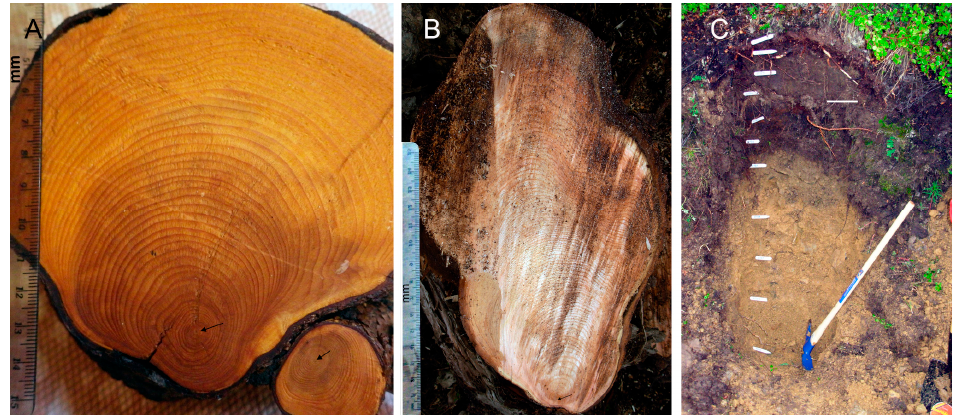
Figure 6. ( A ) A cross-section at one metre from the root collar through two horizontal roots; the smaller root at lower right egresses from the larger and was growing buried within tundra, whereas the larger root was above the tundra surface. The arrows indicate positions of the root centres in their first years. ( B ) Cross-section of an older horizontal root. The arrow at bottom indicates the centre of the root when it was in its first year. ( C ) Organic soil overlaying solidly frozen colluvium at 1300 m asl on site. The long white bar at right indicates a residual grey tephra layer deposited more than 1200 years ago [19]. The mattock handle is 90 cm in length.